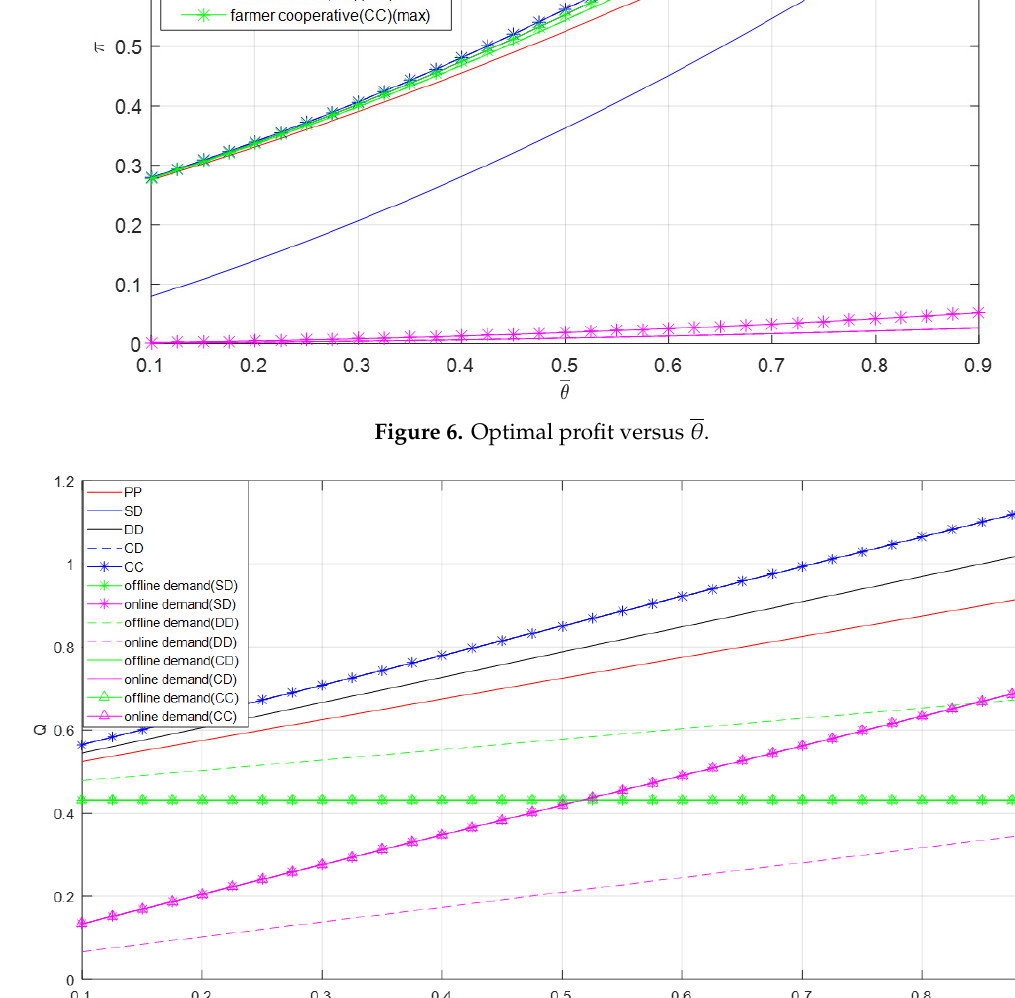
Figure 7. Optimal demand versus θ